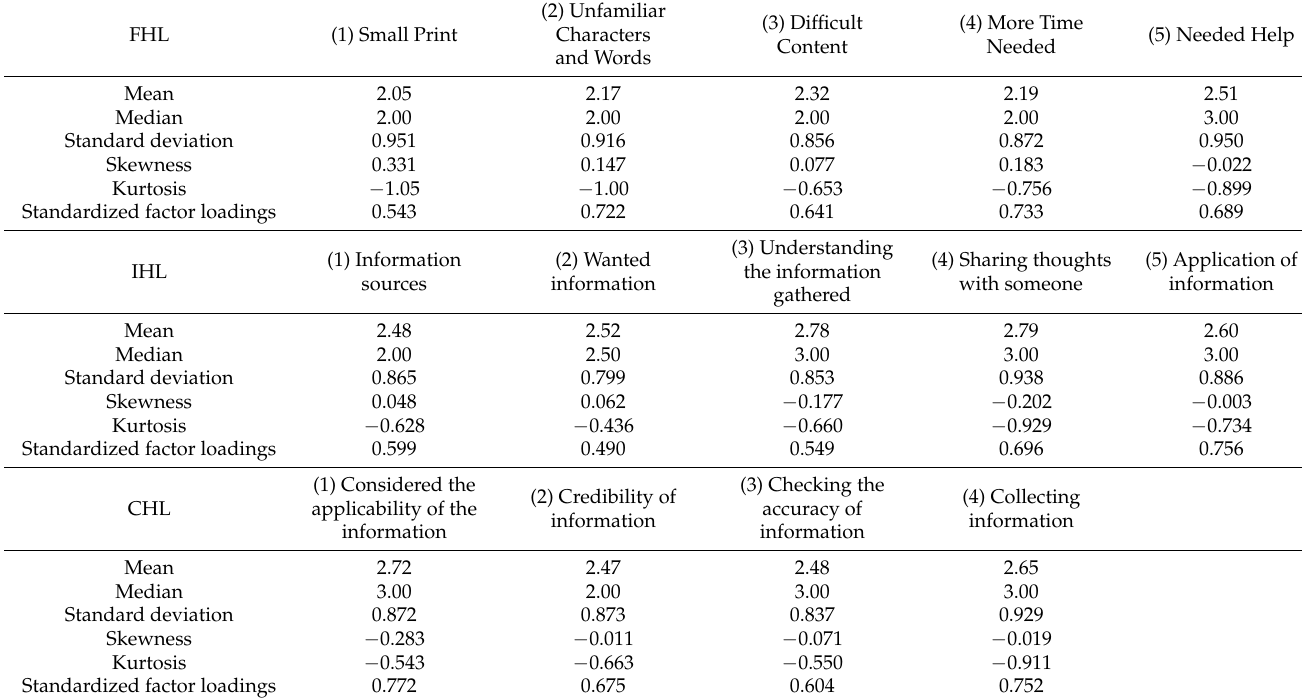
Table 4. Distribution of